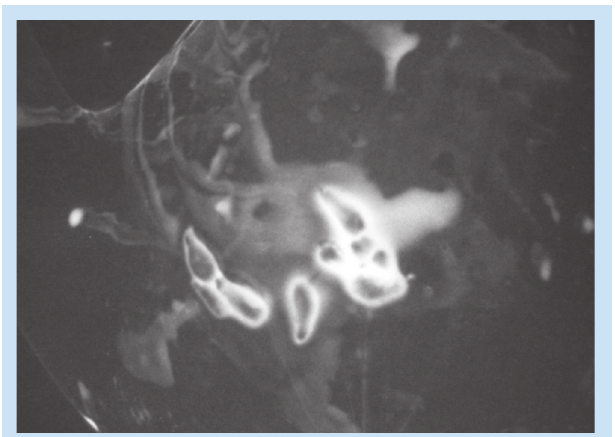
Fig. 1d. Multiple grape pip shadows during simulation in latex